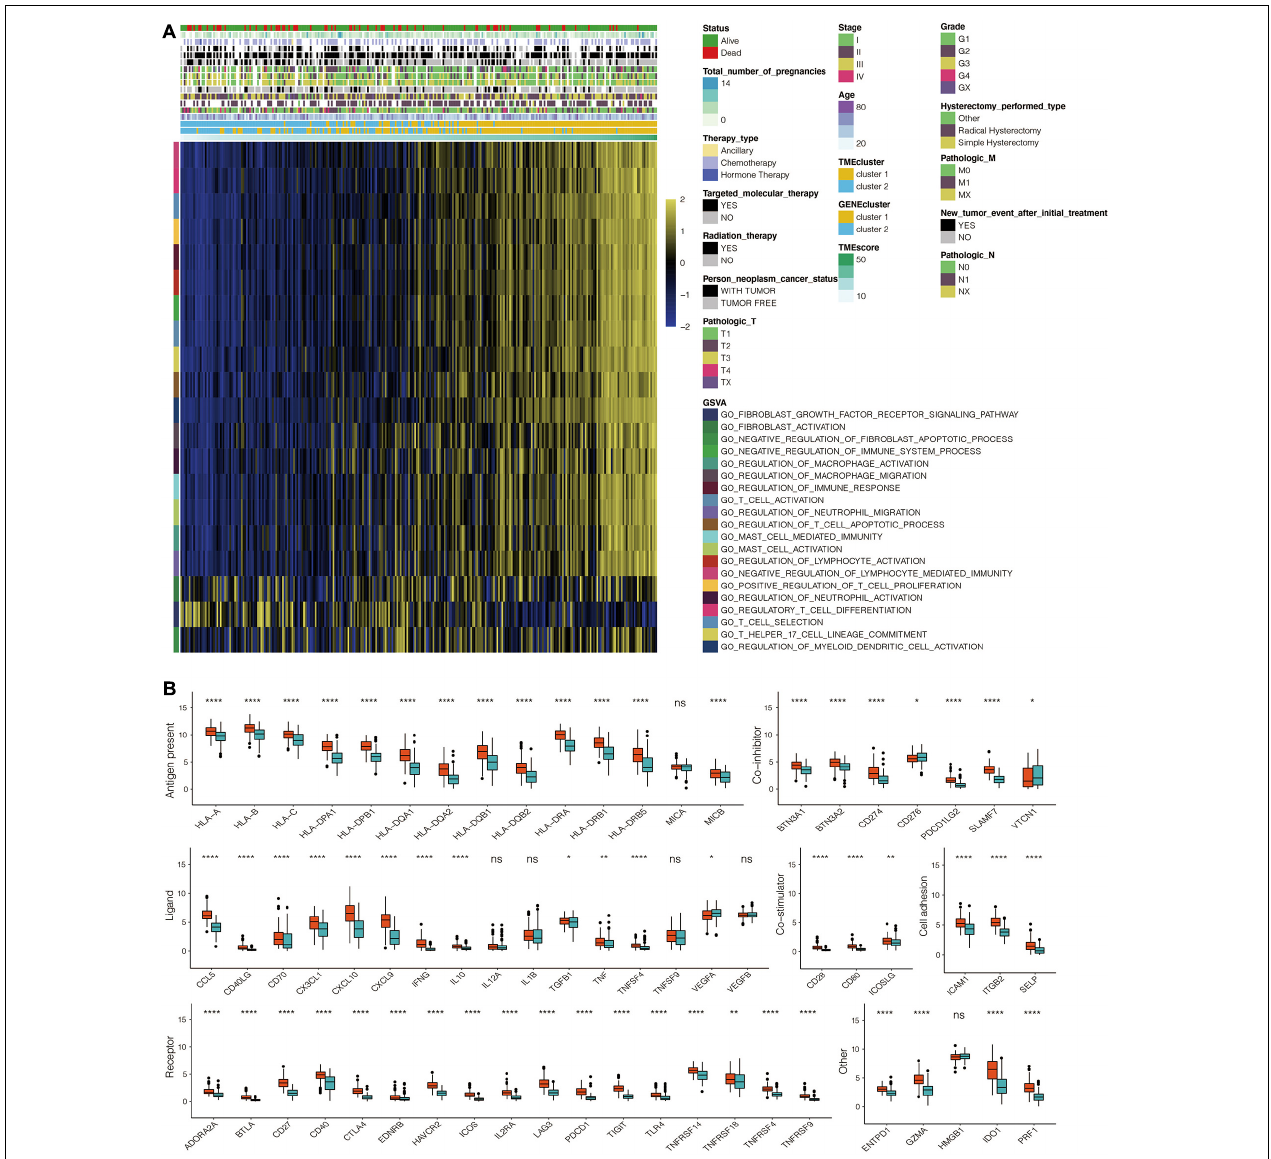
FIGURE 5 | Immune-related functional annotation for the TME score. (A) GSVA for the TME score based on GO for TCGA. (B) The expression pattern of seven types of immune checkpoints in the TME score-based clusters for TCGA. *, P < 0.05; **, P < 0.01; ***, P < 0.001; ****, P < 0.0001; ns, not statistically